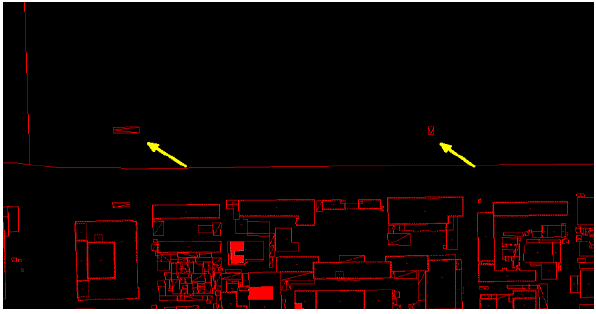
Figure 6 . Repeated collection of houses connected to the border